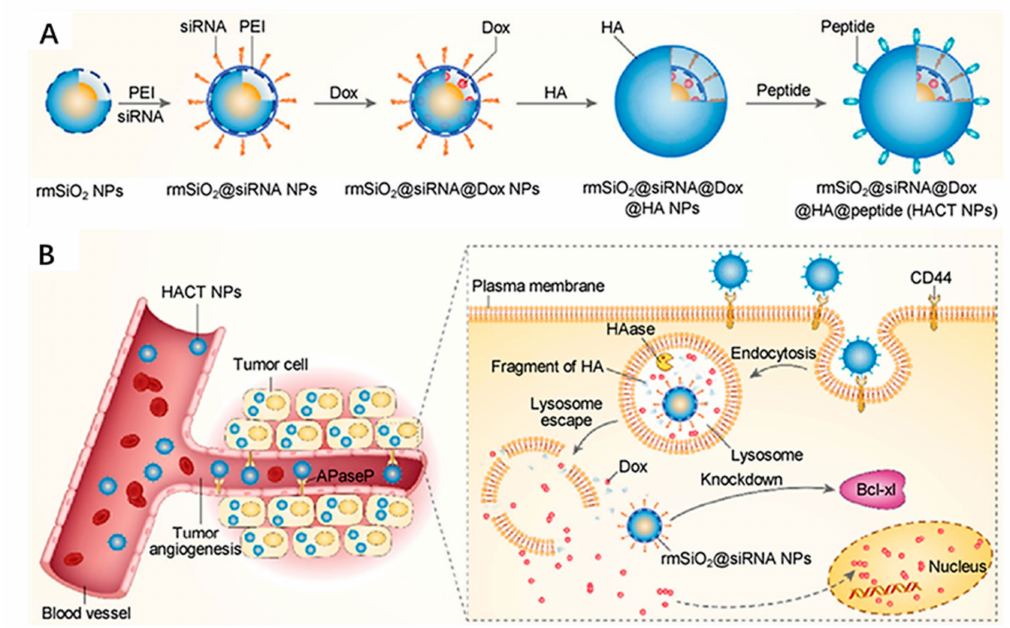
Figure 2. ( A ) Schematic diagram of the construction of HACT NPs with the cascade of two targeting agents (HA and peptide) and two cancer therapeutic agents (siRNA and Dox). ( B ) Schematic illustration of HACT NPs for the treatment of CTGF-overexpressing breast cancer. Adapted from